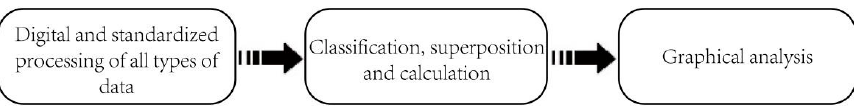
Figure 11. GIS platform use process.